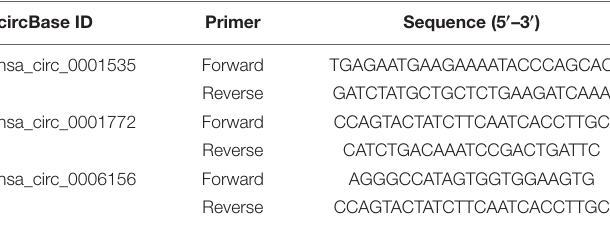
TABLE 1 | Primers used for quantitative PCR (qPCR) validation of the selected circular RNAs